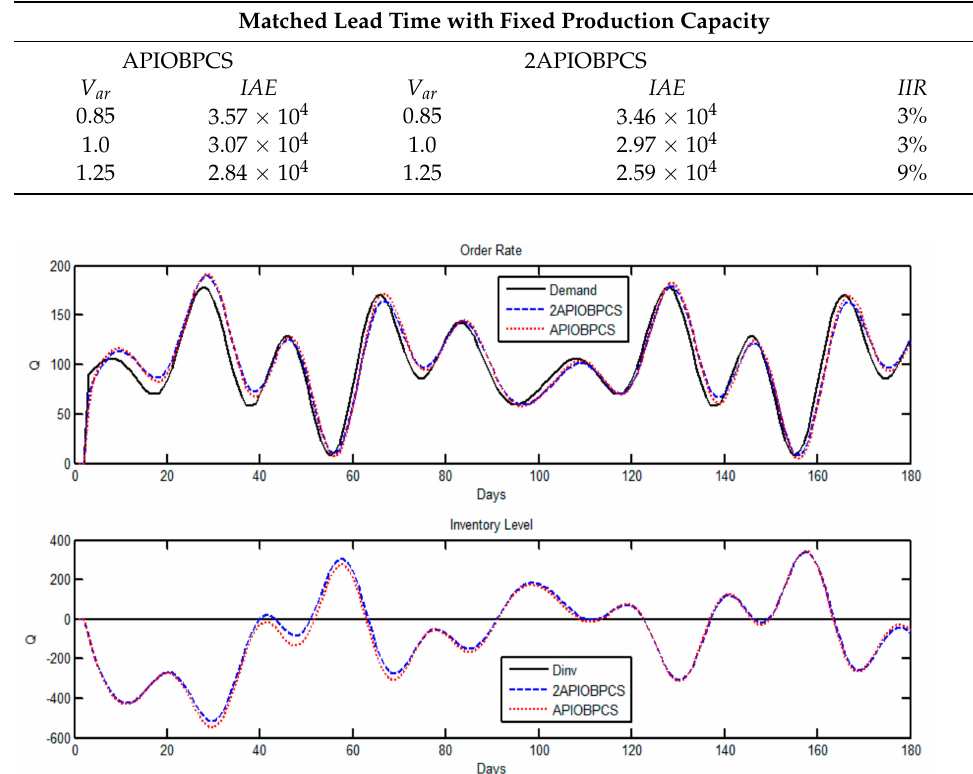
Figure 5. Simulation of Case 1 using Set 2 for the APIOBPCS and 2APIOBPCS models. Order rate ( top ) and inventory level ( bottom ).